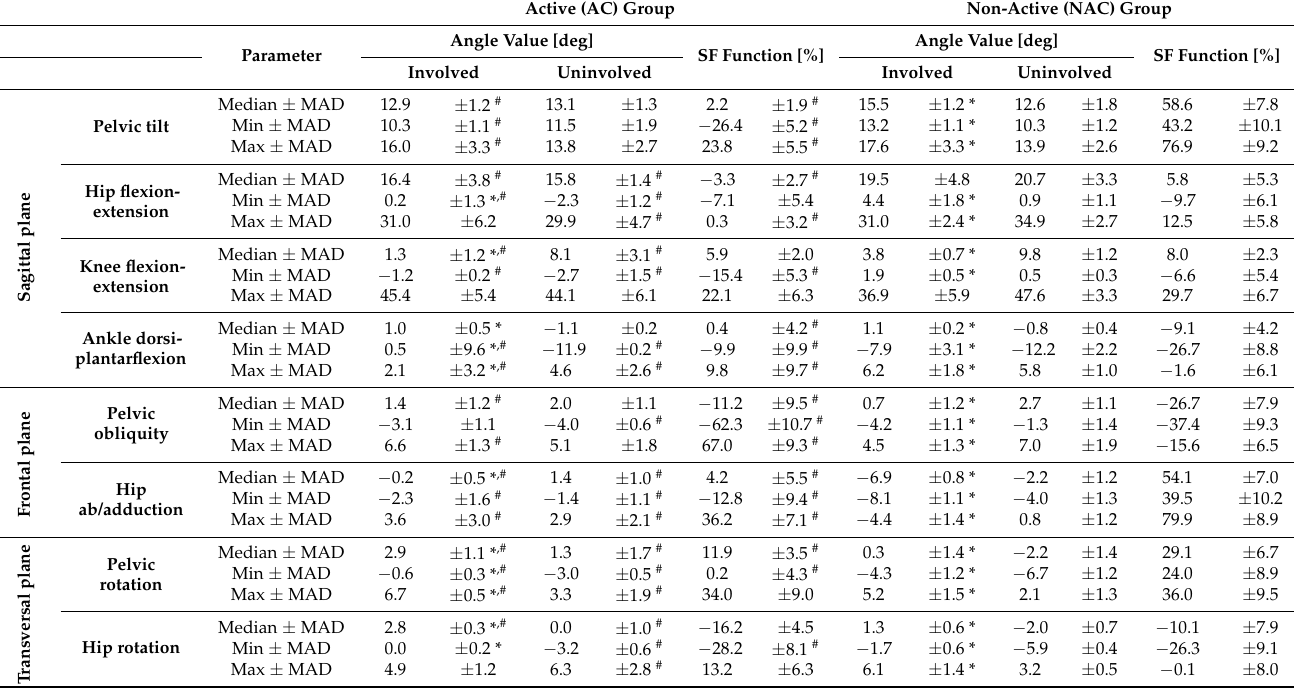
Table 2. Sagittal, frontal and transversal plane kinematic results. Median, minimal, and maximal values and ± median absolute deviation